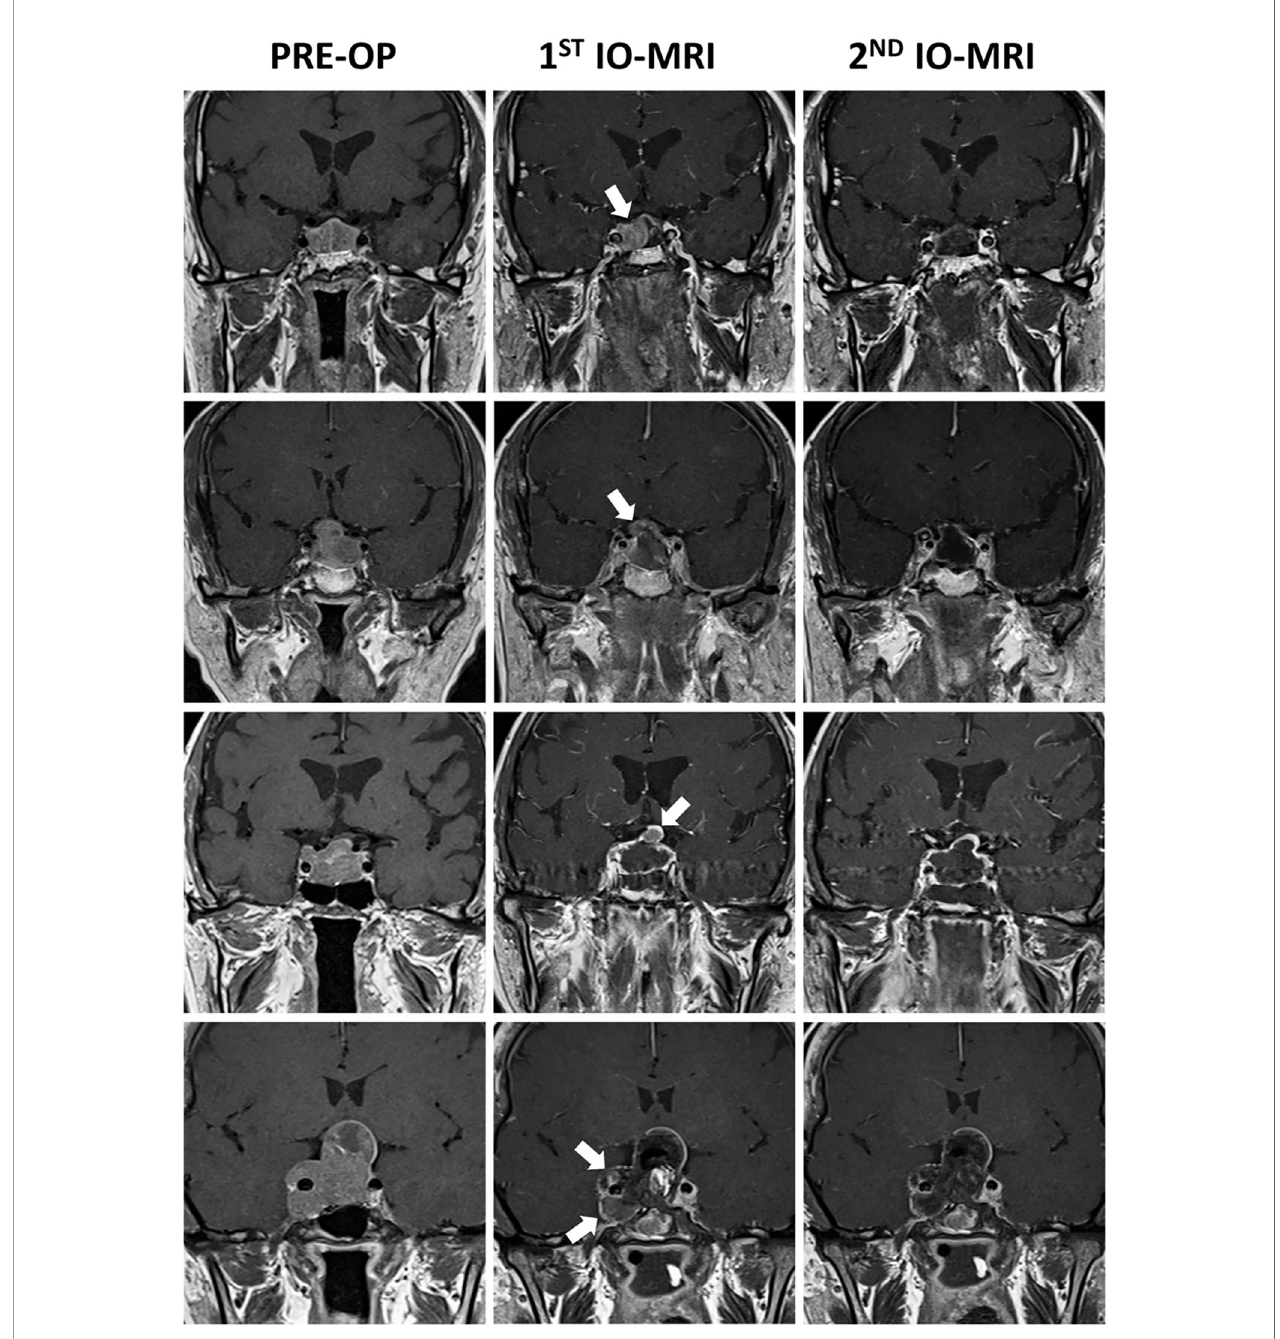
FIGURE 1 | Figure demonstrating pre-operative and intraoperative contrast enhanced coronal T1-weighted pituitary MRIs of 4 different patients. First patient ( fi rst row) had a prolactin secreting macroadenoma which had two different signal intensity on pre-operative MRI scan without any cavernous invasion. Right side of the tumor was showing high signal intensity. First IO-MRI scan demonstrating residual mass on the right side. Second IO-MRI scan demonstrating that total removal was achieved. Second patient (second row) had a non-functioning macroadenoma causing visual disturbance. First IO-MRI scan demonstrating residual mass where tumor was penetrating the sellar diaphragm. Surgeon decided further excision and total removal was achieved. Third patient (third row) had a Knosp Grade 3A growth hormone secreting macroadenoma. Following excision, surgeon ’ s decision was in favor of total removal. However, fi rst IO-MRI scan showed residual tumor was not in the cavernous sinus but in the region where tumor was penetrating the sellar diaphragm. Total removal was achieved following further excision. Last patient (fourth row) had a Knosp Grade 4 non-functioning pituitary adenoma causing severe visual disturbances. Following excision fi rst IO-MRI demonstrated residual mass in the cavernous sinus. Further excision was performed which resulted in total removal of the tumor. Patient had a 3 rd nerve palsy following the surgery which totally improved after 3 months post-operatively. White arrows demonstrating residual tumor tissues on IO-MRIs.